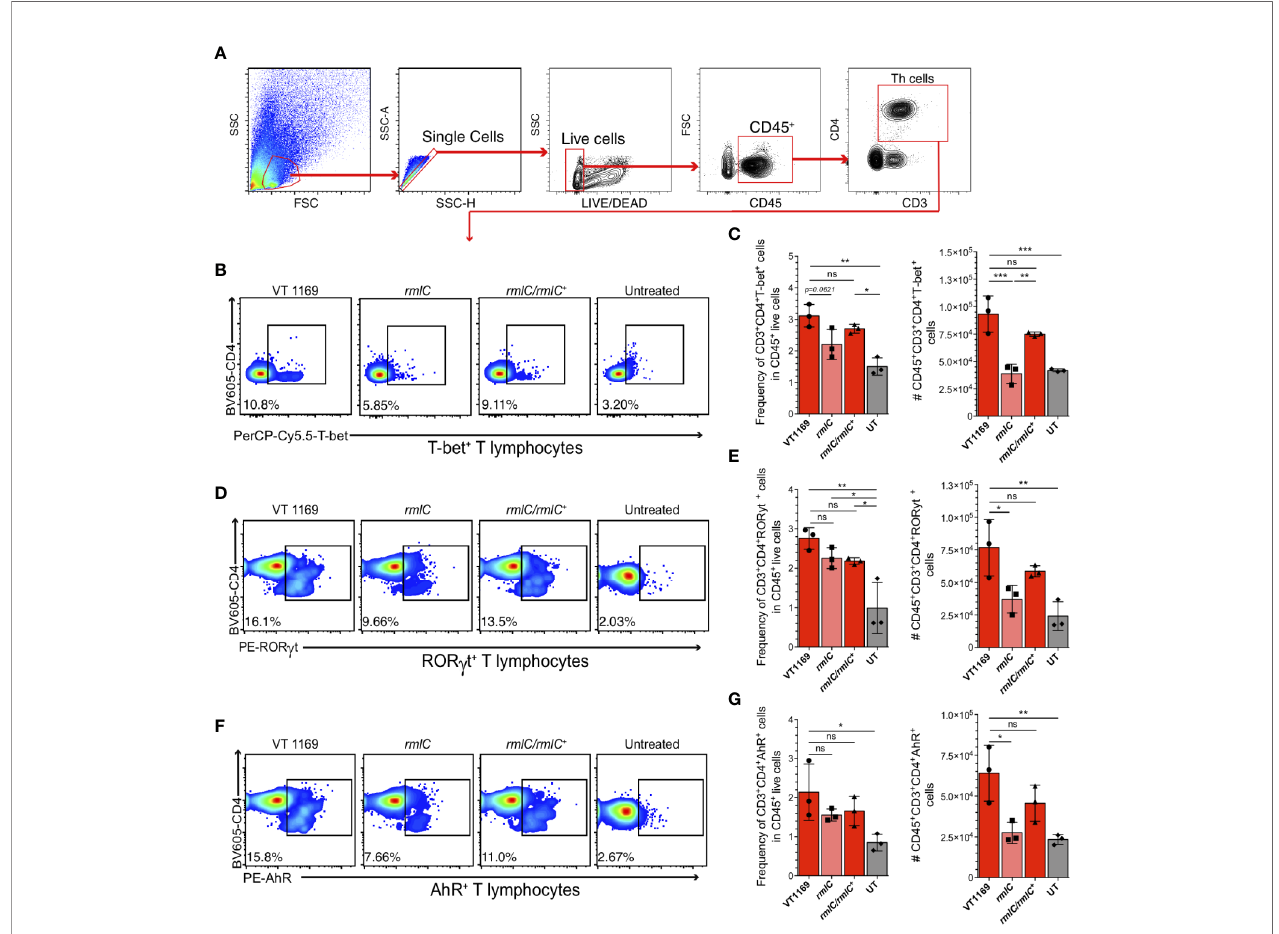
FIGURE 3 | T-bet + , ROR g t + , and AhR + T lymphocytes detection within the periodontal tissues induced by the different strains of A. actinomycetemcomitans . Cells obtained from periodontal tissues were analyzed by fl ow cytometry. (A) Gating strategy used for lineage determination of single/live/CD45 + CD3 + CD4 + T lymphocytes. Flow cytometric quanti fi cation of (B , C) CD45 + CD3 + CD4 + T-bet + Th1 lymphocytes, (D , E) CD45 + CD3 + CD4 + ROR g t + Th17 lymphocytes, and (F , G) CD45 + CD3 + CD4 + AhR + Th22 lymphocytes in periodontal lesions upon infection with the A. actinomycetemcomitans VT1169, rmlC , or rmlC/rmlC + strains, or the untreated (UT) controls. Plots are representative of three independent experiments (n=3). Mean ± SD, one-way ANOVA and Holm-Sidak post-hoc test, *p < 0.05, **p < 0.01, ***p < 0.001, ns, non-signi fi cant. Error bars represent SEM in all